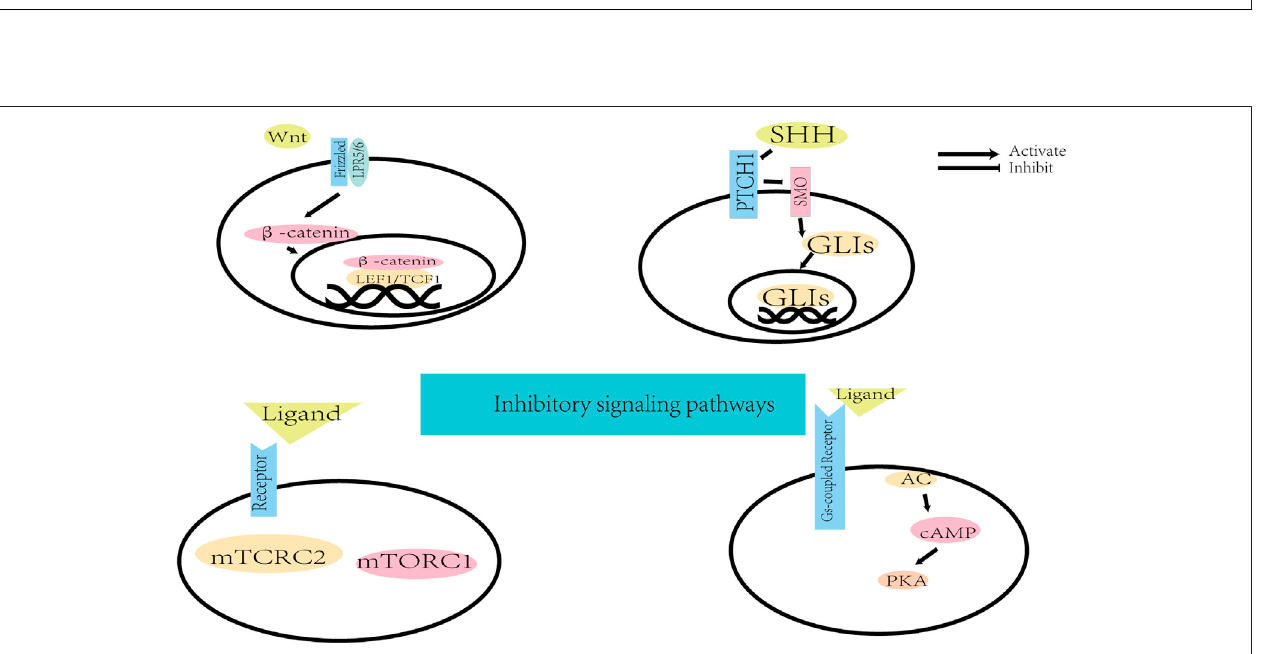
FIGURE 3 | The background information of inhibitory signaling